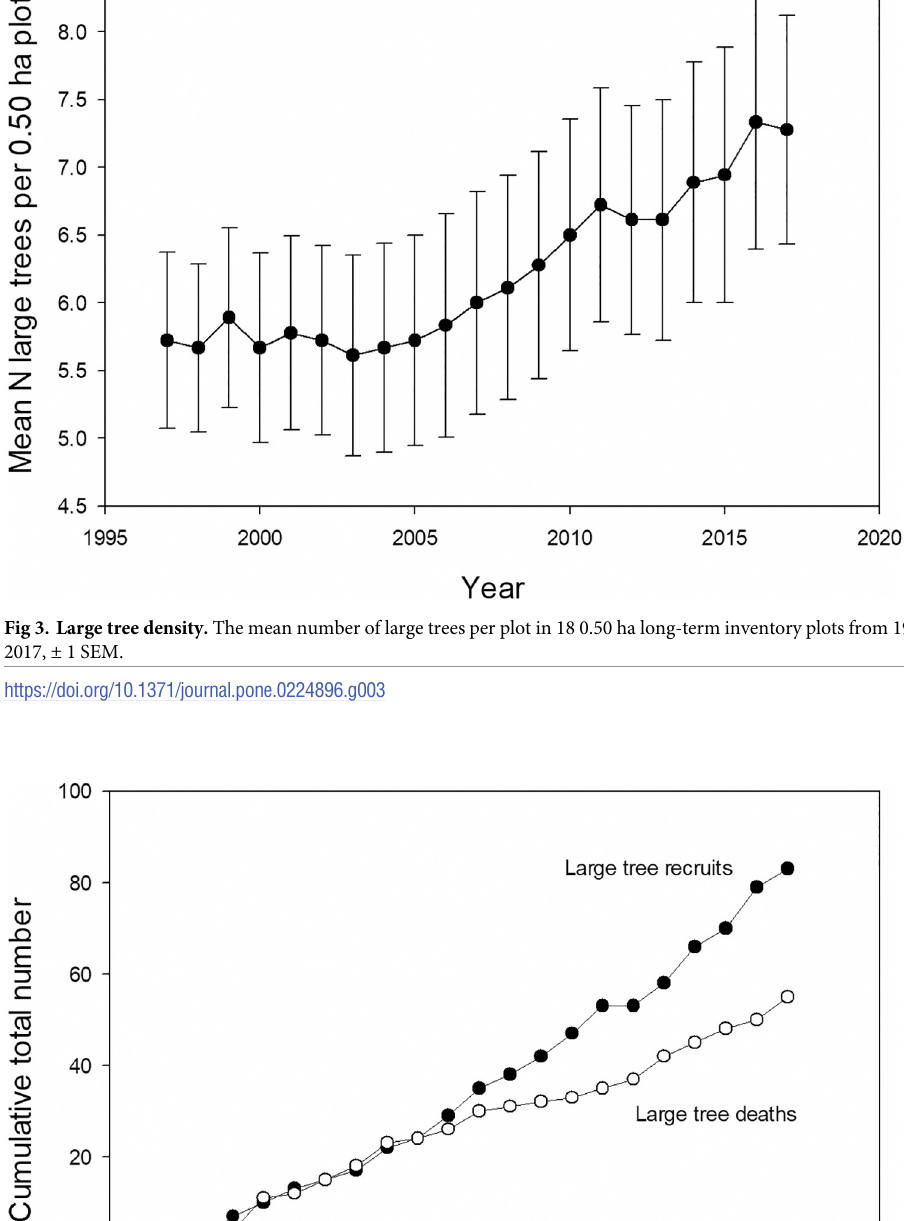
PLOS ONE | https://doi.org/10.1371/journal.pone.0224896 November11,